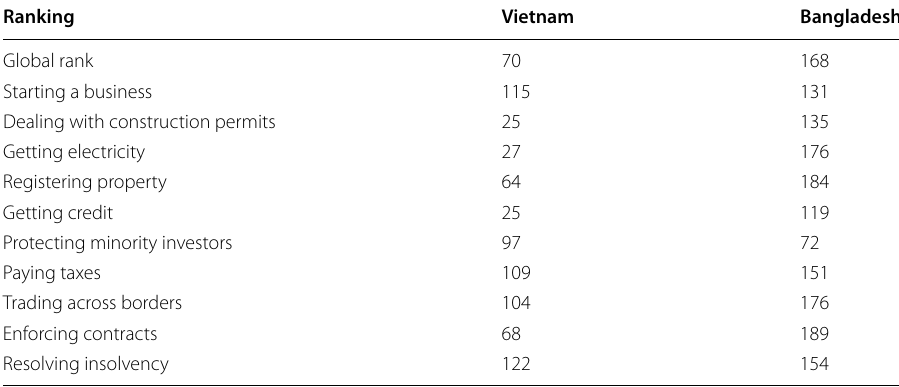
Table 8 Ease of doing business index 2020 Source: Doing Business, The World Bank, 2020.